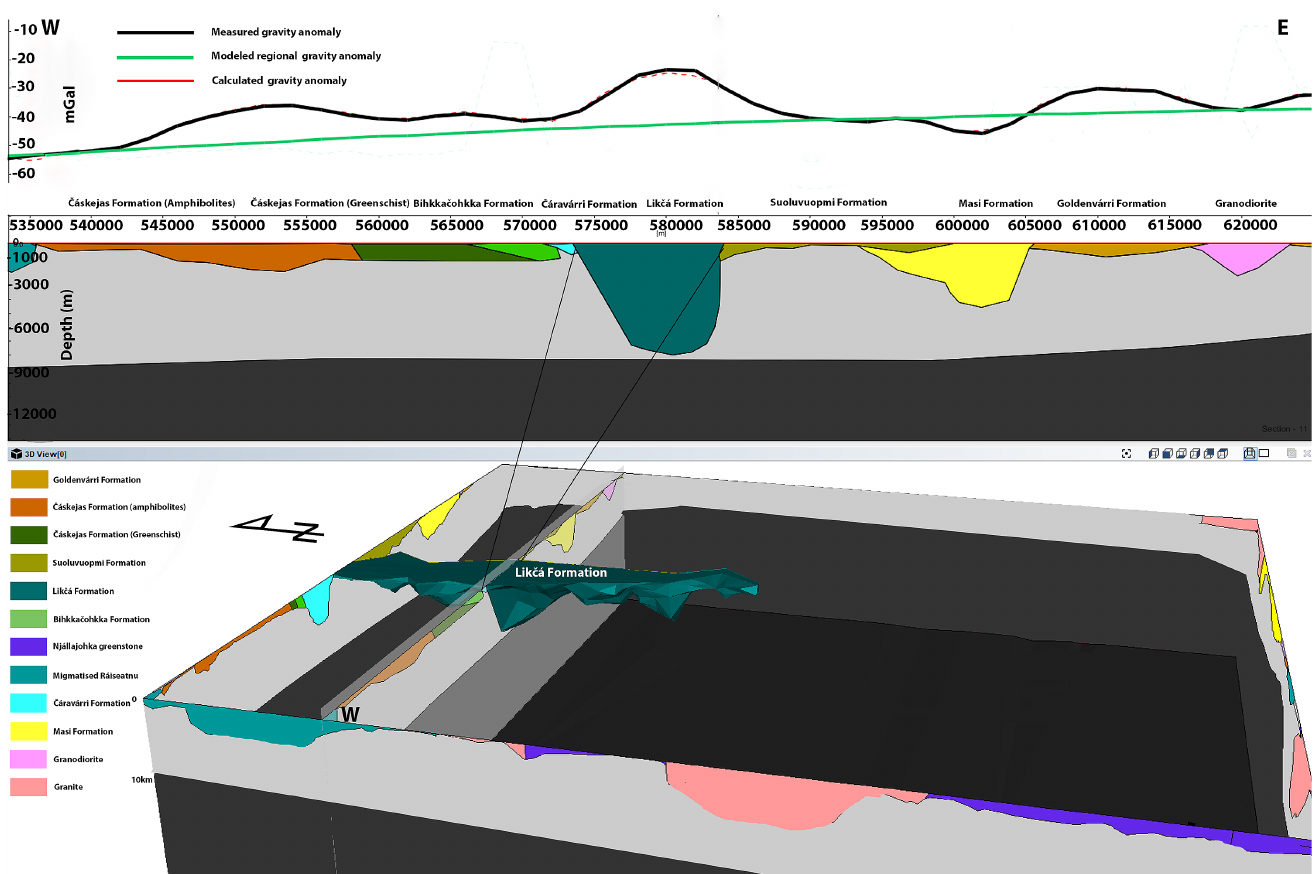
Figure 19. A 2D section and 3D view of the constructed model. The top panel shows a 2D section from the model with the main lithological units. The lower panel shows the 3D modelled structure of the Likčá Formation.